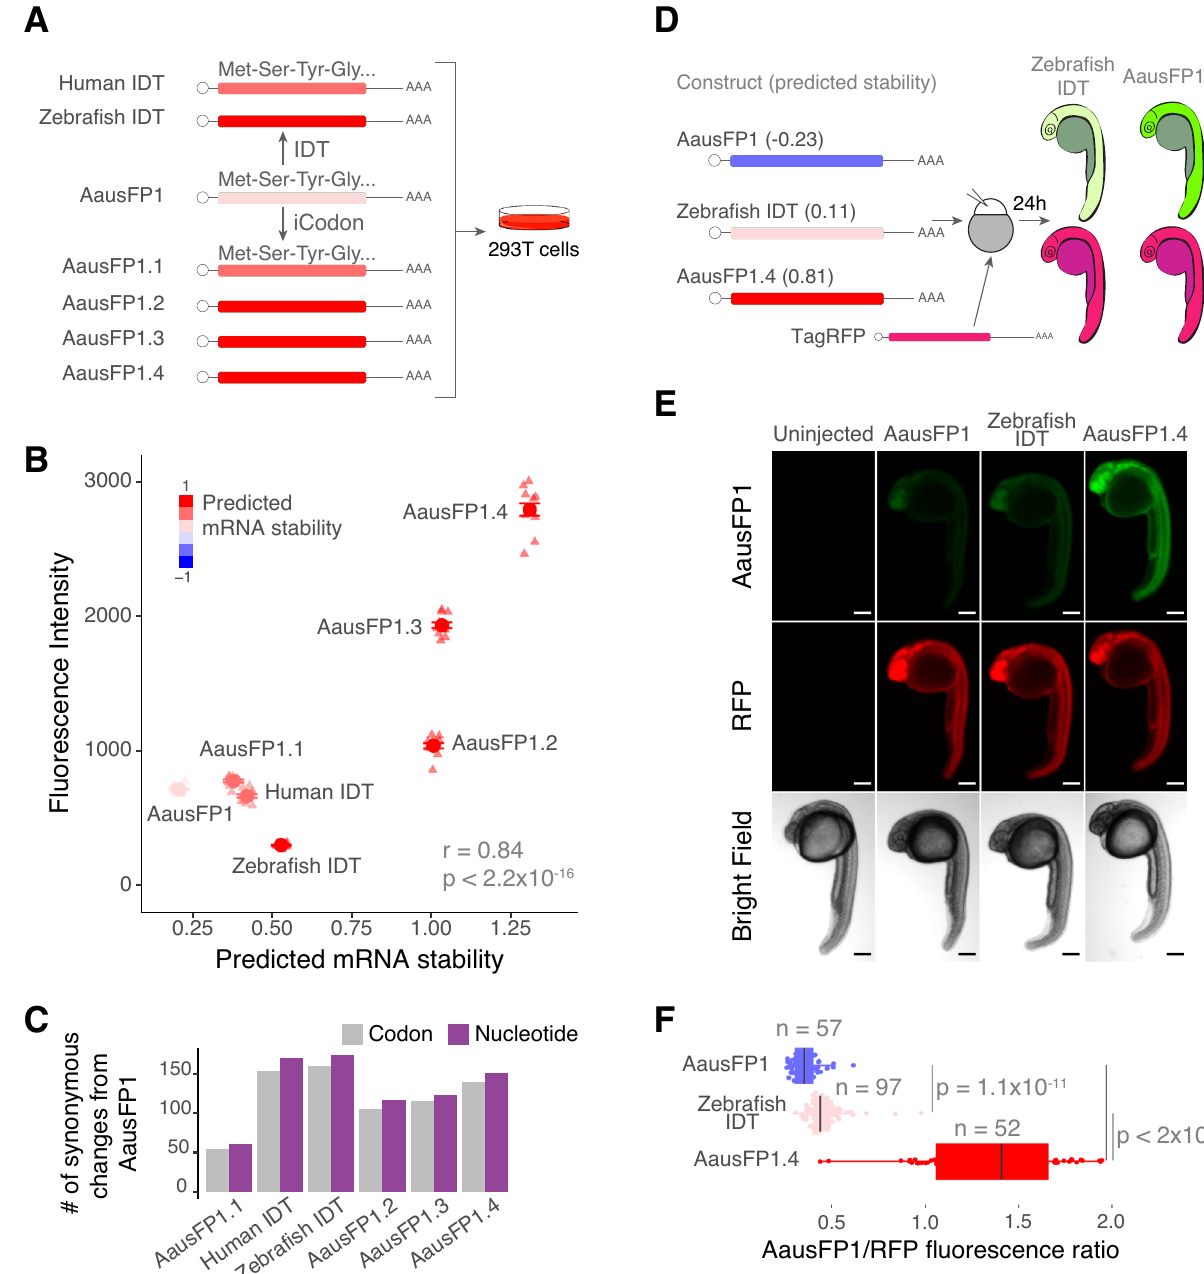
Figure 4. iCodon optimizes fluorescent AausFP1 variants for expression in vertebrates. ( A ) Diagram of the AausFP1 variants optimized by iCodon or by IDT Codon Optimization Tool that were transfected in 293T cells. ( B ) Scatter plot showing a positive correlation between predicted mRNA stability and AausFP1 fluorescence intensity in 293T transfected cells (r = 0.84, p < 2.2 × 10 –16 , Pearson correlation test). n = 12 for all tested variants. ( C ) Bar plot showing the number of codon (gray) or nucleotide (purple) changes in AausFP1 variants compared to the original sequence. ( D ) Three AausFP1 variants were co-injected with TagRFP into 1-cell stage zebrafish embryos and imaged 24 h post injection (hpi). The mRNA stability predictions by iCodon in zebrafish are indicated in brackets. ( E ) Microscopy images of injected zebrafish embryos after 24 hpi. Scale bars represent 200 µm. ( F ) Quantification of the differences of fluorescence intensity of AausFP1 relativized by RFP fluorescence from injected zebrafish embryos. p values and replicates (n) are